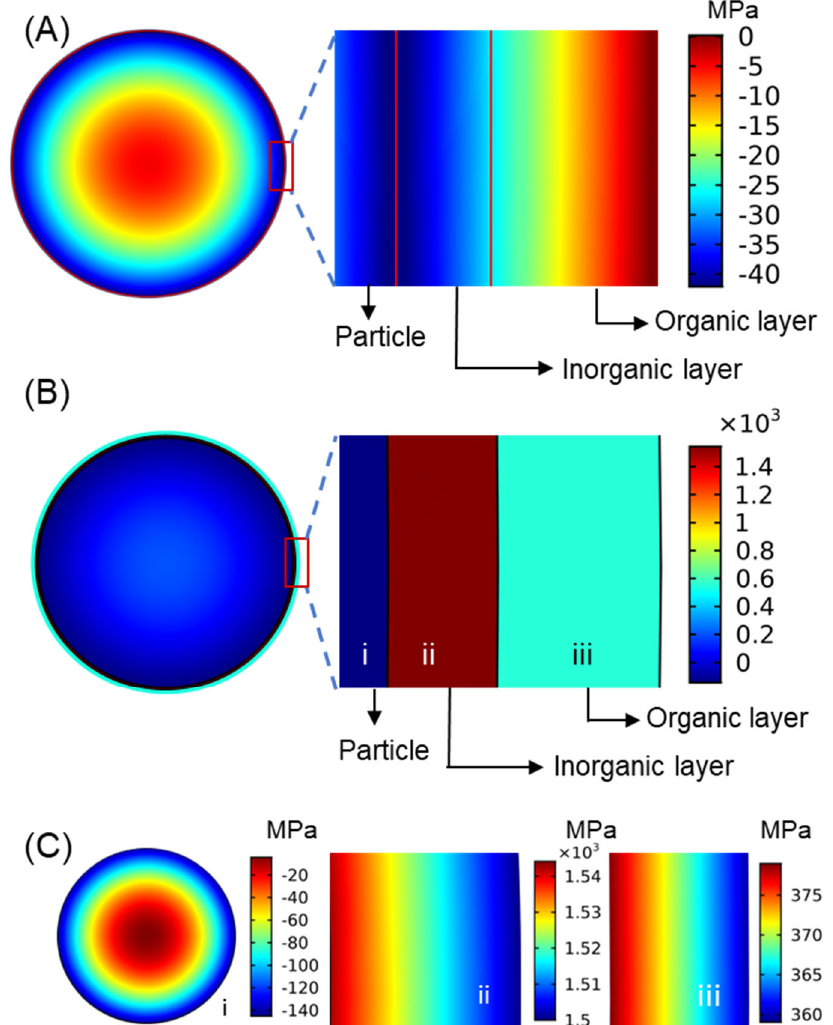
Figure 3. Stress contours in the particle and SEI layer at the end of 2000 cycles. ( A ) Radial stress with magnified view in the inorganic and organic SEI layers. ( B ) Tangential stress with magnified view in the inorganic and organic SEI layers. ( C ) Detailed tangential stress distribution (i) inside the particle, (ii) inorganic SEI layer, and (iii) organic SEI layer. The results are plotted for h SEI = 0.4.